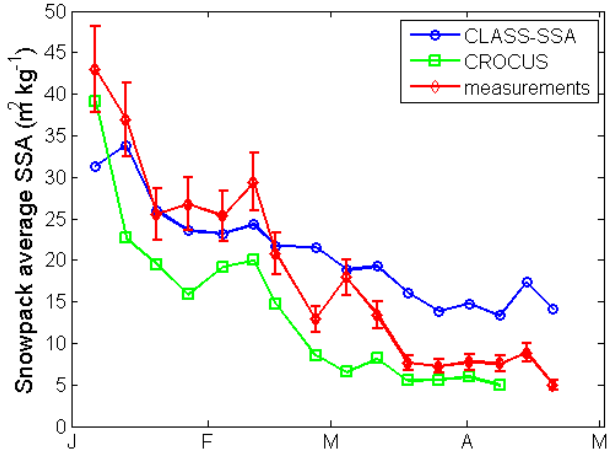
Fig. 9. Snowpack-averaged SSA evolution with time at Col de Porte for CLASS-SSA, Crocus (Morin et al., 2013) and the measure- ments. The last Crocus value was excluded because the simulations give no snow on ground. Error bars on measurements are the mea- surements accuracy (12%: Gallet et al.,